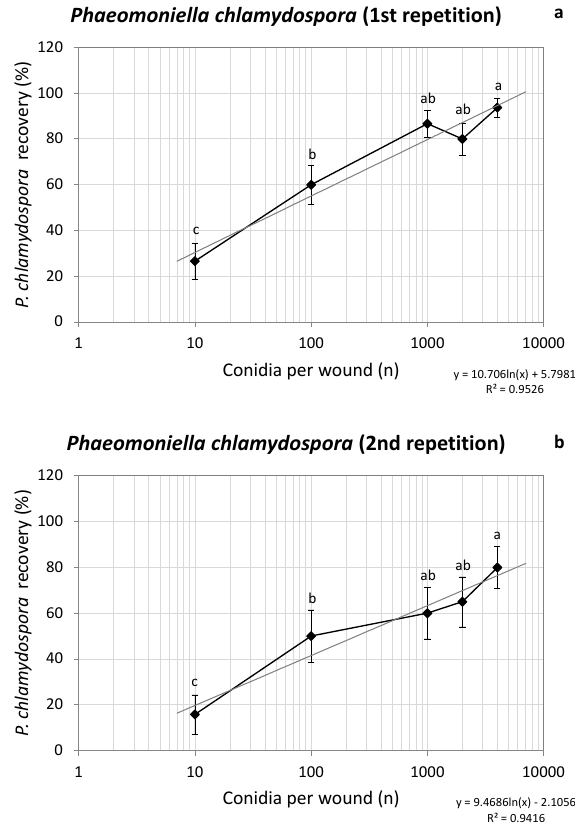
Figure 2. Mean percentage recovery from the two potted vine (cv. Tempranillo) experiments inoculated with Phaeo- moniella chlamydospora . Twenty replications (canes) per pathogen were used for each experiment and two canes per vine allocated with each inoculum dosage of 10, 100, 1000, 2000 or 4000 conidia/wound. Significant differences among means ( P <0.05) are indicated by different letters. Bars correspond to the standard error of the